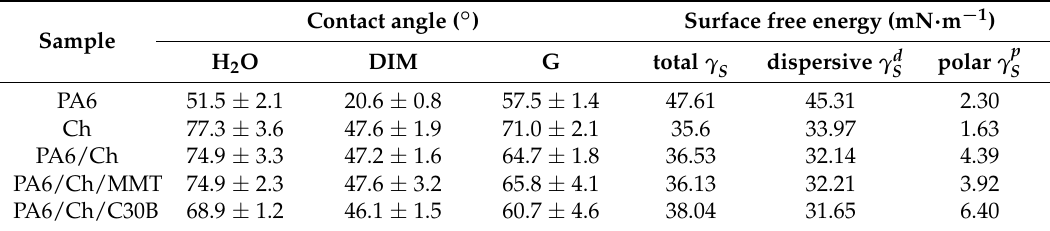
Table 4. Contact angle ( ◦ ) and surface free energy values for PA6 support and composite chitosan